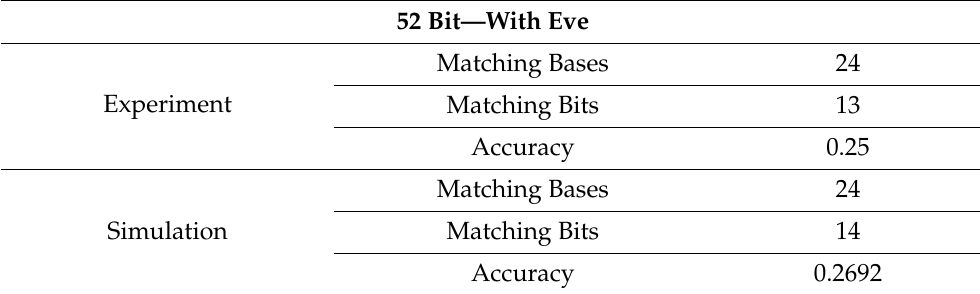
Table 8. A 52 bit accuracy for experiment and simulation—with Eve.